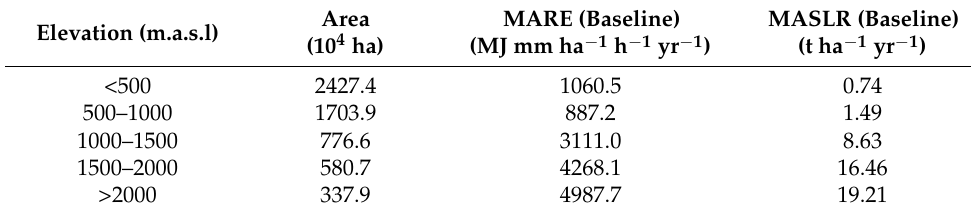
Table 11. Baseline soil erosion rates by elevation in